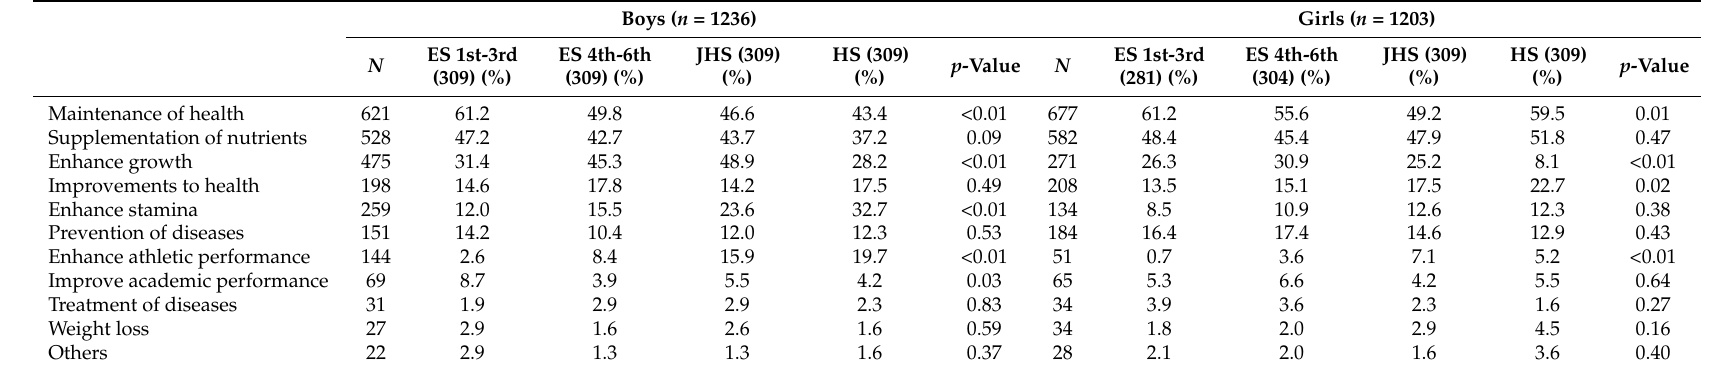
Table 5. What is the purpose of dietary supplement